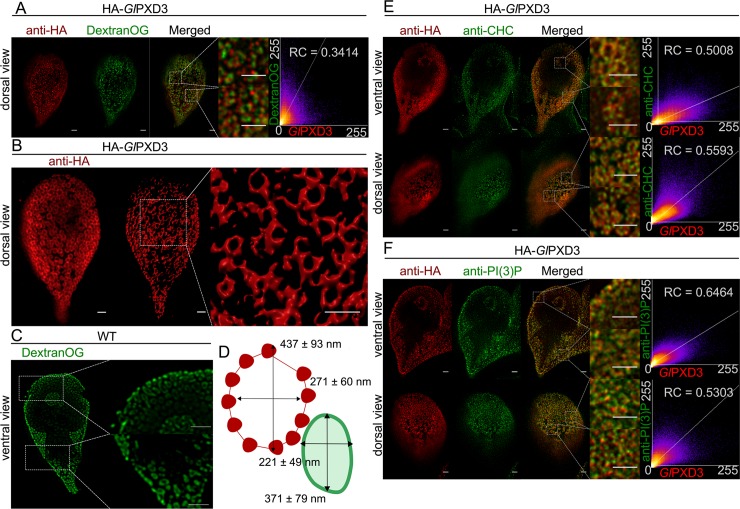
GlPXD3 membrane coats as a tool to probe PV size and organization.(A) A dorsal view of representative cells expressing an epitope-tagged GlPXD3 reporter (red) and co-labelled for Dextran-OG (green). STED confocal imaging followed by signal overlap analysis (scatter plot) shows proximal yet distinct deposition patterns, with GlPXD3 reporters closely associated to Dextran-OG-illuminated PVs. Scale bars: whole cell 1 μm; close-ups 1 μm. (B) 3D STED microscopy (left panel) followed by reconstruction using IMARIS (middle panel) of a representative cell expressing an epitope-tagged GlPXD3 reporter reveals fenestrated GlPXD3-delimited areas distributed under the PM and throughout the whole cell (close-up view of inset in the right panel). Scale bars: whole cell 1 μm; close-ups 1 μm. (C) STED microscopy analysis of PVs in a representative non-transgenic wild-type cell labelled with Dextran-OG. Scale bars: whole cell 1 μm; close-ups 1 μm. (D) Average length of the major and minor principle axes of GlPXD3-delimited fenestrated structures (in red) and Dextran-labelled PV organelles in wild-type non-transgenic cells (in green) measured across at least 100 structures/organelles. (E) STED confocal microscopy analysis of ventral and dorsal views of a representative cell expressing an epitope-tagged GlPXD3 reporter (anti-HA) and co-labelled for GlCHC (anti-CHC) shows how fenestrated GlPXD3-delimited structures are decorated with GlCHC foci. Scatter plots are included for signal overlap analysis. Scale bars: whole cell 1 μm; close-ups 1 μm. (F) Similar to GlCHC, anti-PI(3)P antibodies (anti-PI(3)P) detect foci of PI(3)P accumulation in close proximity to GlPXD3 epitope-tagged reporters (anti-HA) in HA-GlPXD3-expressing cells analyzed with STED microscopy. Scatter plots are included for signal overlap analysis. Scale bars: whole cell 1 μm; close-ups 1 μm.